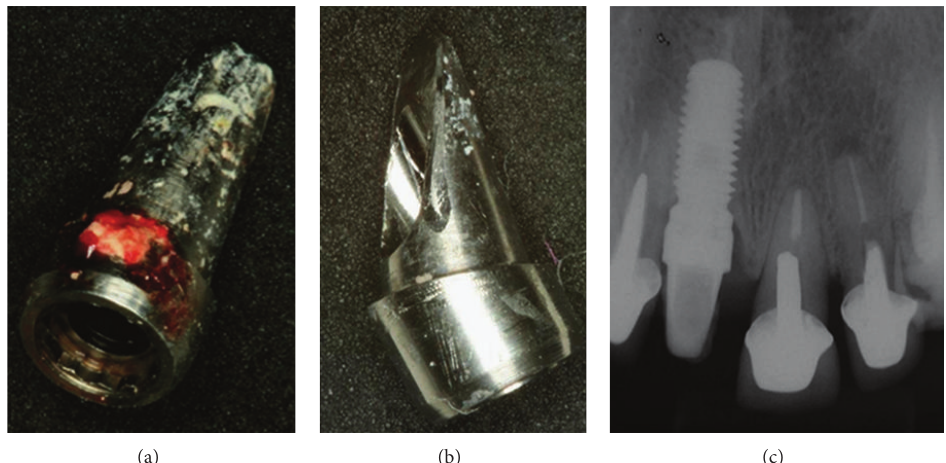
Figure 3: (a) Right maxillary central incisor abutment removed. (b) Angled abutment to correct the implant malpositioning; (c) periapical radiograph revealed endodontic treatment of the left maxillary central incisor and the left maxillary lateral incisor and the root resorption of left maxillary lateral incisor.